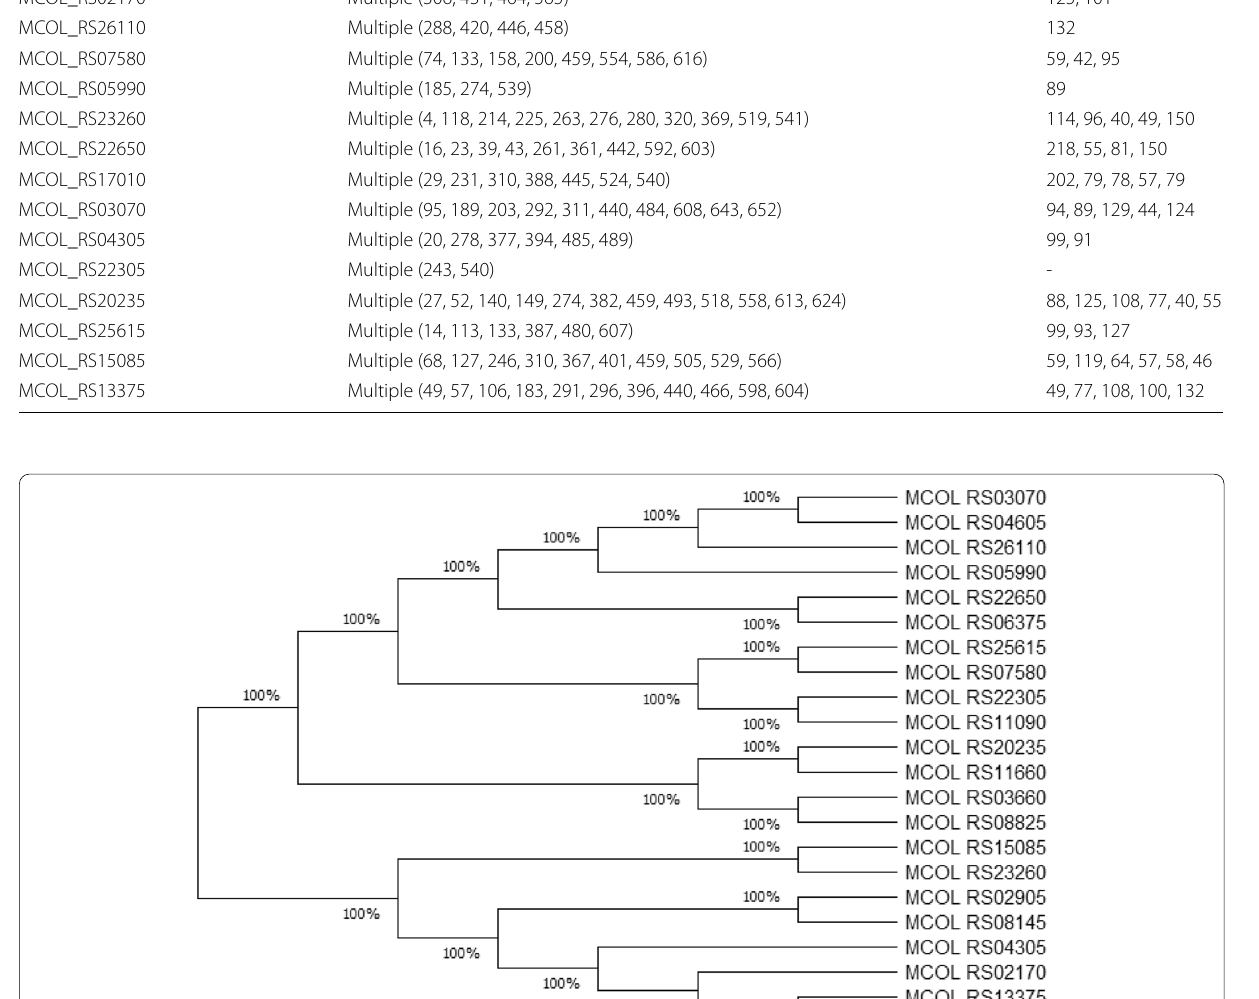
metabolism; 2 LexA families, involved in survival by inducing SOS response upon DNA damage and salt stress management; 2 bacterial histone-like protein fami- lies, involved in metabolism of aromatic compounds and